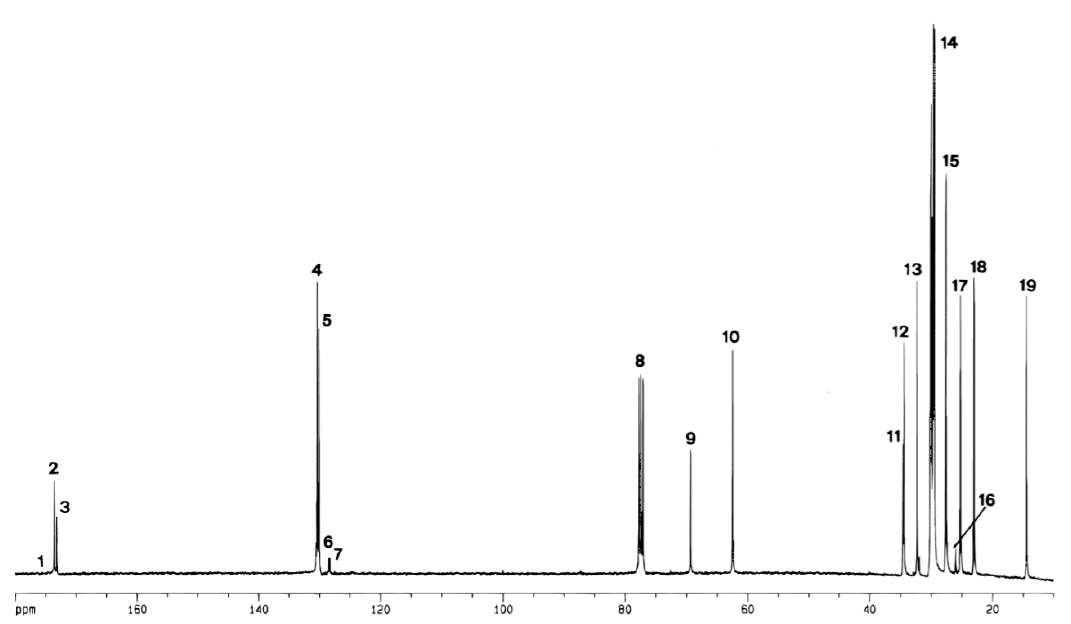
Figure 4. 13 C NMR spectrum of a virgin olive oil in CDCl 3 . Target peaks 1 to 3 in the carbonyl region correspond respectively to: C1 of free fatty acids (174–176 ppm), C1 in 1,3- sn position of triacylglycerols (173.26 ppm) and C1 in sn -2 position of triacylglycerols (172.81 ppm). For full assignment, see Table 2 of [52]. The spectrum was acquired with broadband proton decoupling on a Bruker AM 400 MHz spectrometer at 303 K, using 16 K data points, with an acquisition time of 0.37 s, a 45 ◦ flip angle and a relaxation delay of 5 s. Reprinted from Magnetic Resonance in Chemistry , Vol 35, R. Sacchi, F. Addeo, L. Paolillo, “ 1 H and 13 C NMR of Virgin Olive Oil. An Overview” (pages S133–S145), copyright (1997), with permission from John Wiley and Sons.